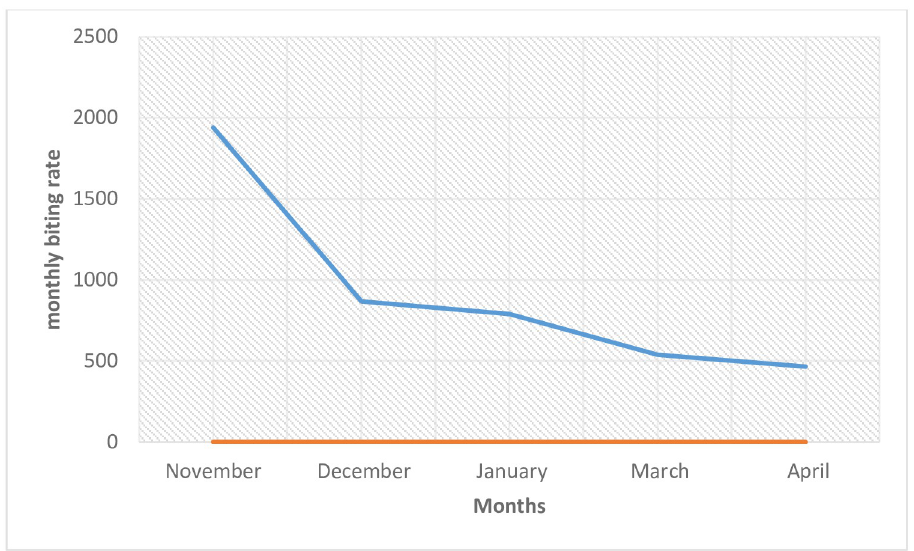
Fig 2. Monthly biting rate of Simulium damnosum complex in the study area.